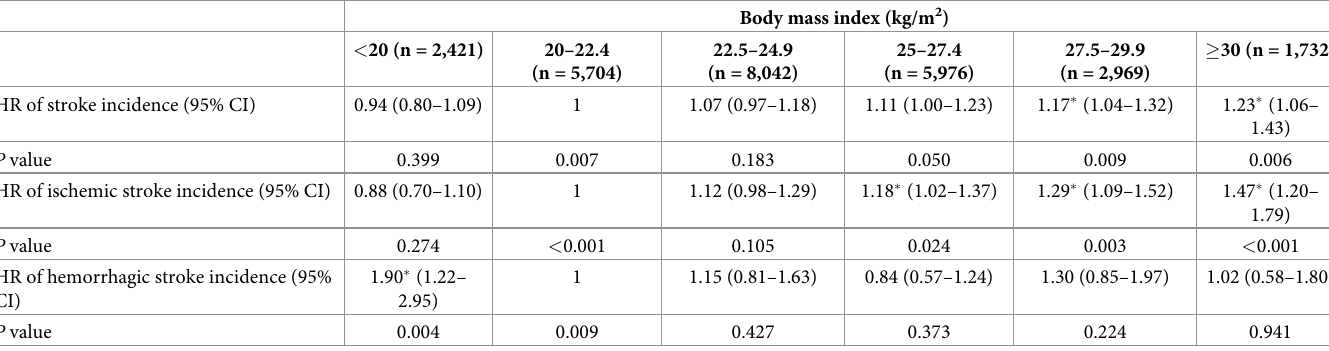
Table 3. Hazard ratios for stroke risk by different categories of body mass index among women with diabetes